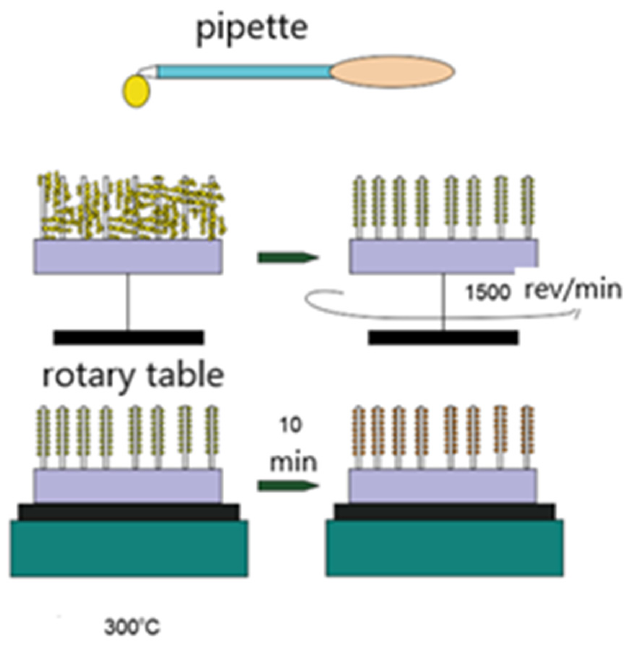
Figure 1. Schematic representation of Fe 2 O 3 spin-coating deposition.